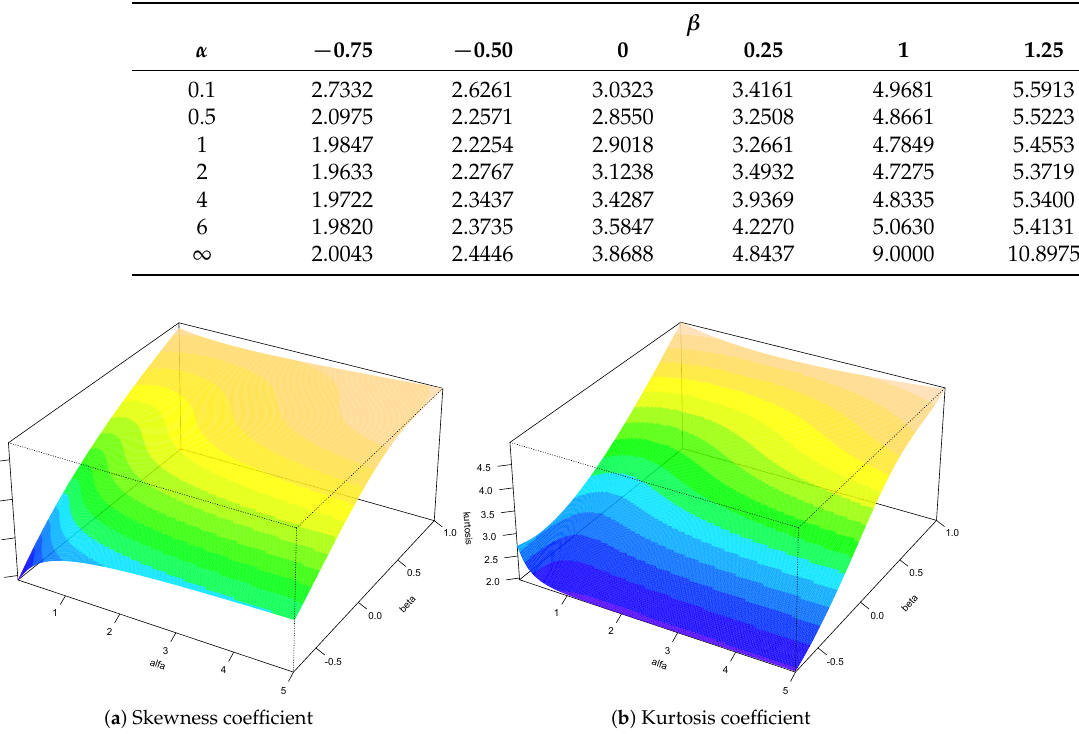
Figure 4. ( a ) Skewness coefficient for EHPE ( α , δ = 1, β ) model and ( b ) Kurtosis coefficient for EHPE ( α , δ = 1, β )